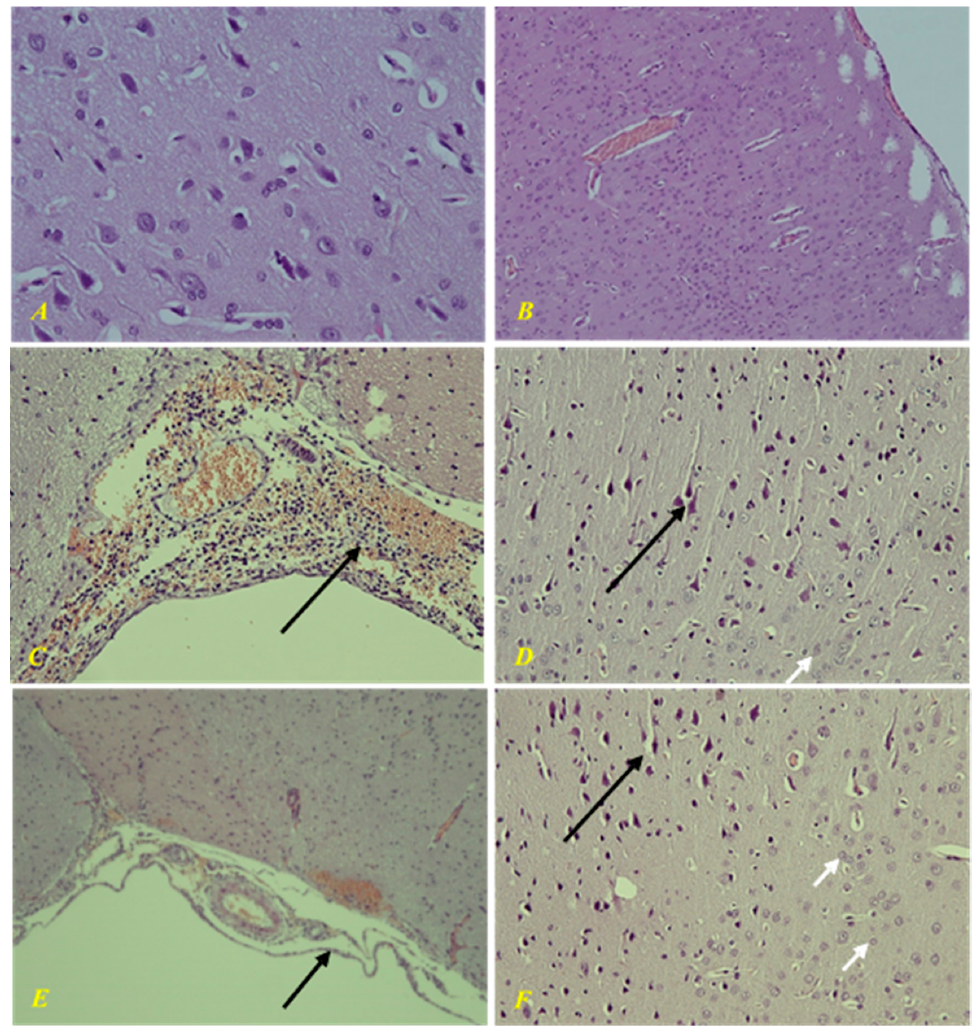
Figure 12. ( A,B ) Healthy brain, no damage; ( C , D ) The second group (control). ( E , F ) Third group (using 2-ethyl-3-methyl-3-hydroxypyridine-2,6-dichlorophenyl (amino)benzoate in a dose of 25 mg/kg). ( C ) Purulent-hemorrhagic meningitis, ( E ) Serous meningitis, black arrow—infiltration of the meninges. ( D ) Perivascular and pericellular edema, black arrow—ischemic/degenerative changes in neurons in the form of changes in the shape and size of neurons, their hyperchromia, wrinkling of individual neurons with pathological tortuosity of apical dendrites; ( F )—with minimal changes. ( A , B , D , F )—magnification: 400×, ( C , E )—magnification: 200×.